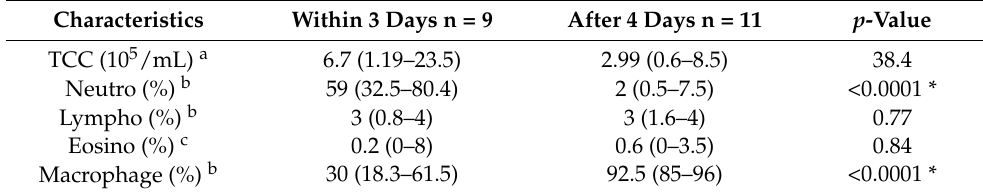
Table 2. Comparison of BALF within 3 days of waterproof spray inhalation and after 4 days.